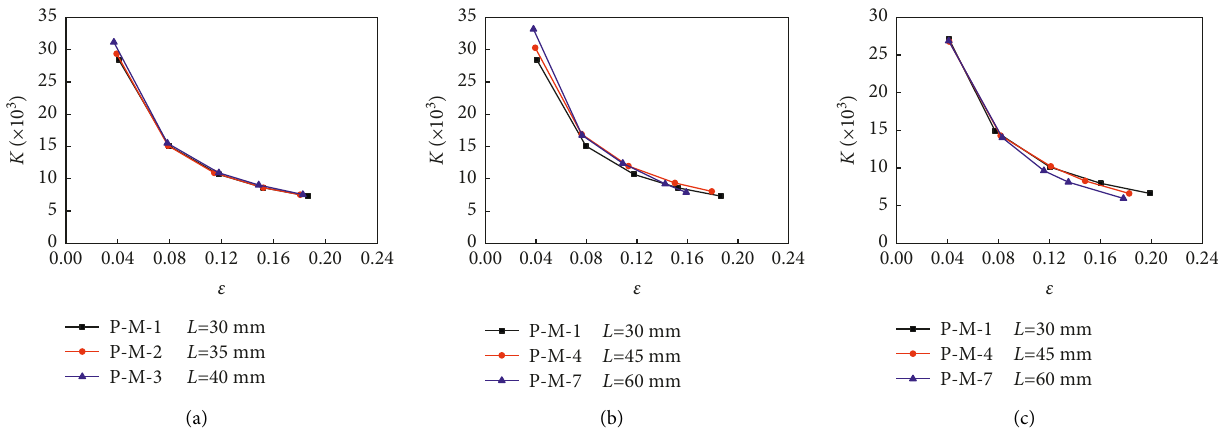
Figure 23: Stiffness degradation of material specimens with different tensile lengths. (a) Specimens with small length in the tension zone. (b) Sheet-shaped specimens with larger length in tension zone. (c) Rod-shaped specimens with larger length in tension